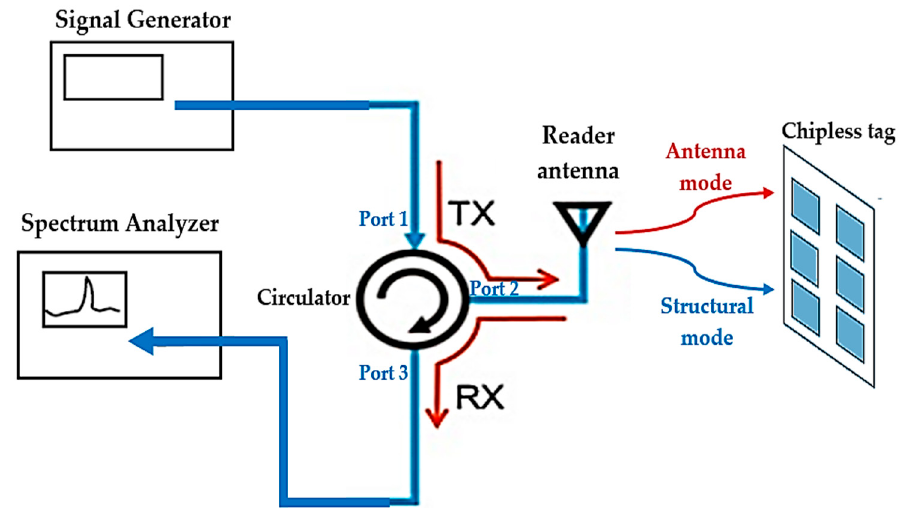
Figure 12. The reader antenna connected to a circulator with a spectrum analyzer and a signal generator to receive the amplitude spectra of the structural mode and the antenna mode in the chipless tag.